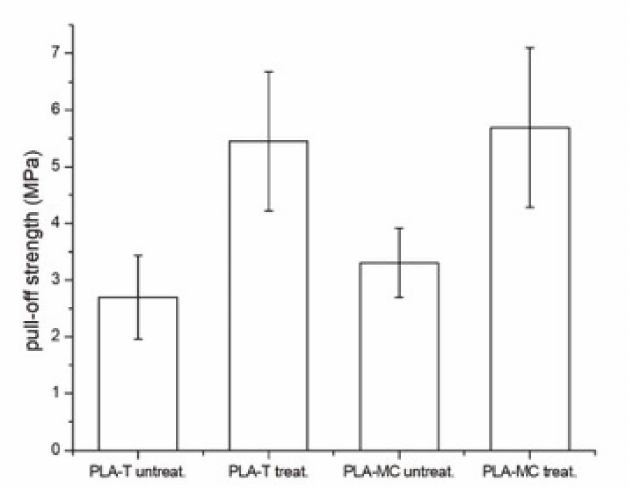
Figure 7. Pull-off test results of the bondline in PLA-laminated oak